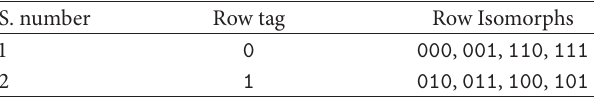
Table 5: The isomorphs for both logic “ 0 ” and logic “ 1 .”